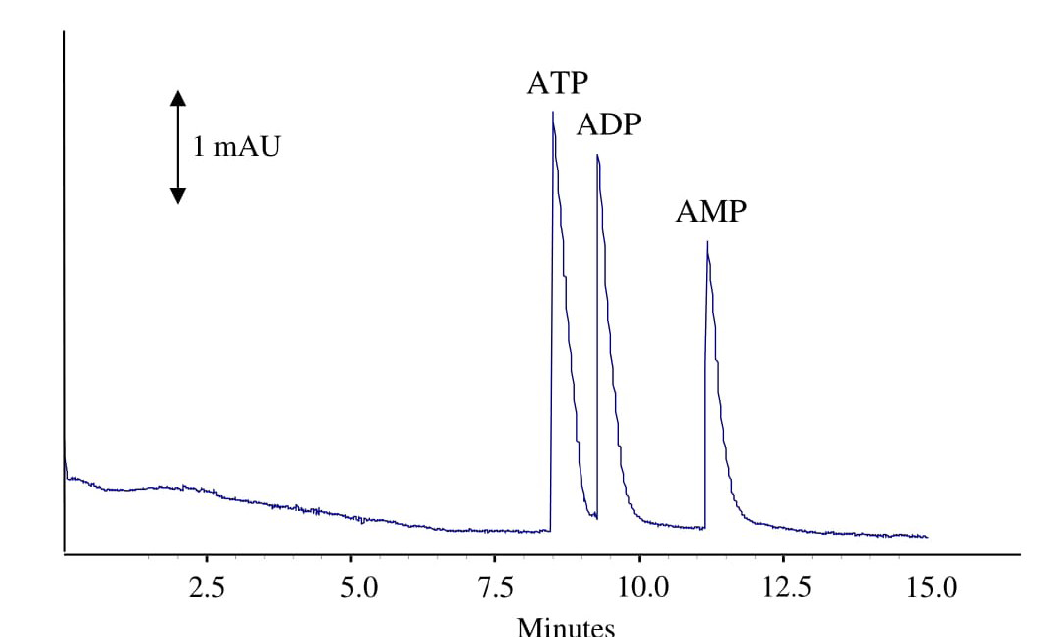
FIGURE 3 - CE separation of a 0.5 mM mixture of ATP, ADP, and AMP standards: 0.1 M tris buffer with 0.5 mM TTAC and 0.30 mg mL –1 HPMC with 25 µm i.d.x 63.5 (53.5) cm in length capillary at field strength of –433 V/cm and UV detection at 254